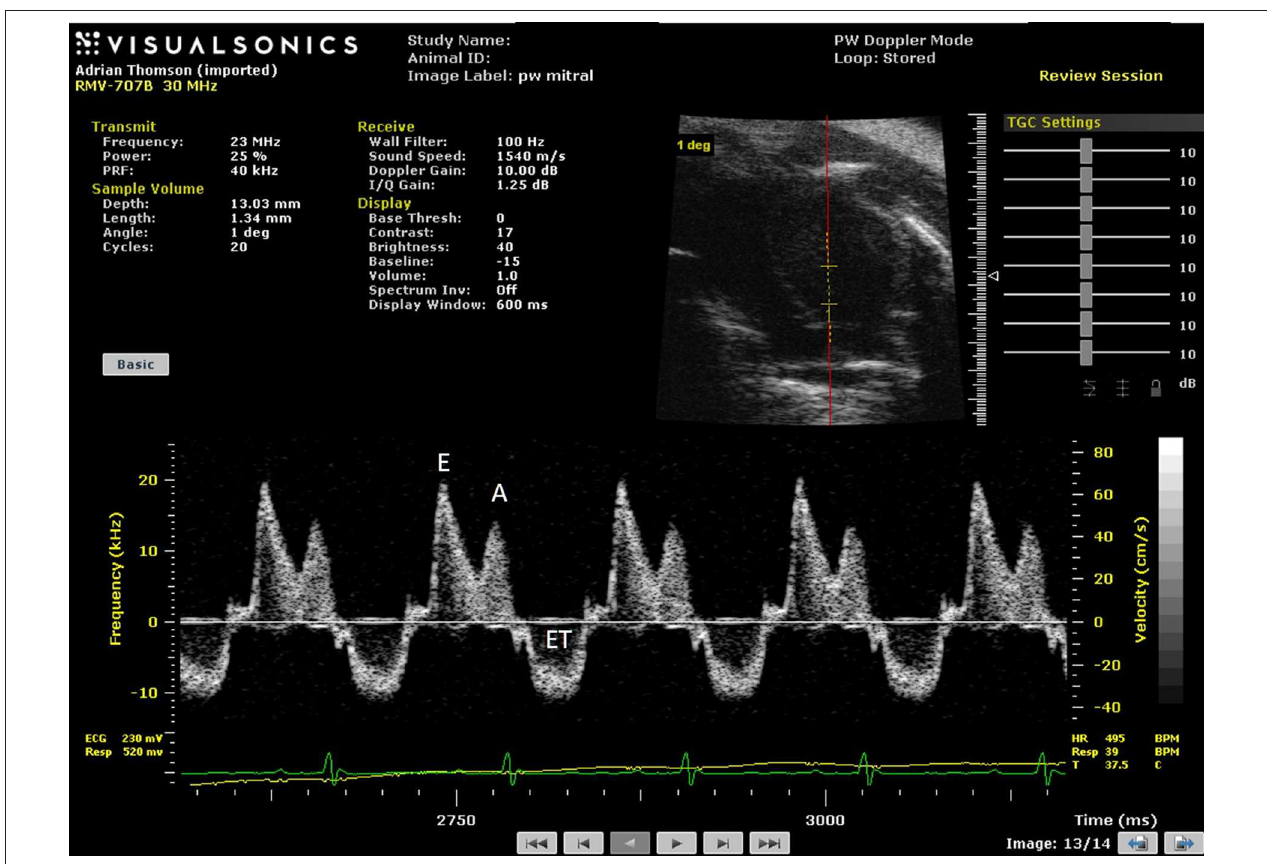
FIGURE 4 | Spectral Doppler trace with Doppler sample volume situated in center of left ventricle enables both inflow and outflow from the left ventricle to be measured with early (E) and late (atrial—A) waves and ejection time (ET) highlighted in the spectral Doppler trace. In addition isovolumic relaxation time (IVRT) and isovolumic contraction time (IVCT) may be measured where IVRT is equal to the time from the closure of the aortic valve to opening of mitral value and IVCT is the time of closure of mitral valve to opening of aortic